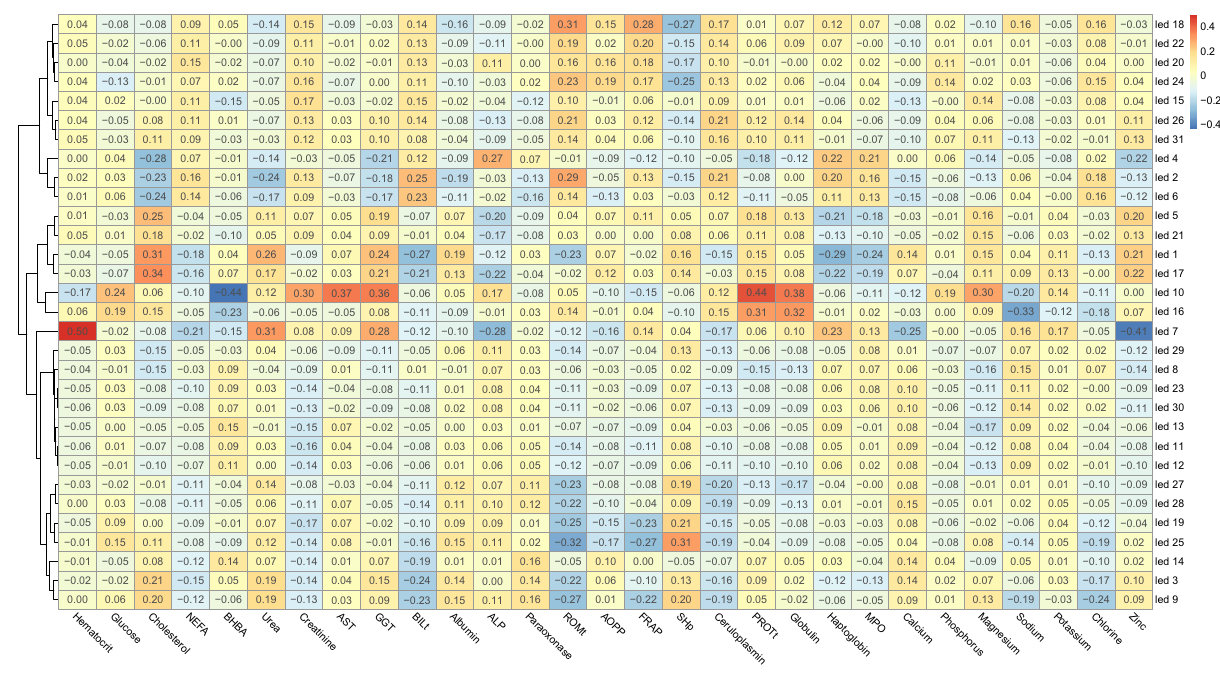
Figure 1. Pearson correlations heatmap between light emitting diodes (LEDs) information and blood metabolites in all Holstein–Friesian cows involved in the trial. On the left side, unsupervised hierarchical clustering of LEDs is showed as a dendrogram. NEFA non-esterified fatty acids, BHBA β-hydroxybutyric acid, AST aspartate aminotransferase, GGT γ-glutamyl transferase, BILt total bilirubin, ALP alkaline phosphatase, PON paraoxonase, ROMt total reactive oxygen metabolites, AOPP advanced oxidation protein products, FRAP ferric reducing antioxidant power, SHp thiolic groups, PROTt total proteins. Graphics have been created using the corrplot R package within the R software v. 3.6.3 (www.r- proje ct.